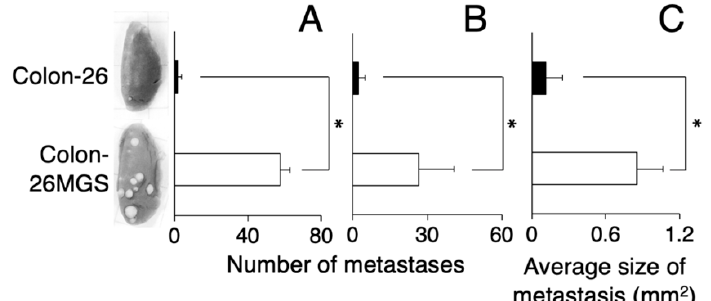
Figure 1. Comparison of metastatic ability between Colon-26MGS and Colon-26. Number of lung metastasis by subcutaneous injection ( A ) and by intravenous injection ( B ) of cancer cells, and size of lung metastasis nodules ( C ) of cancer-bearing mice. Five mice were analyzed per group. * p < 0.05 by Student’s t -test. Bars indicate standard error calculated using data from three independent trials.